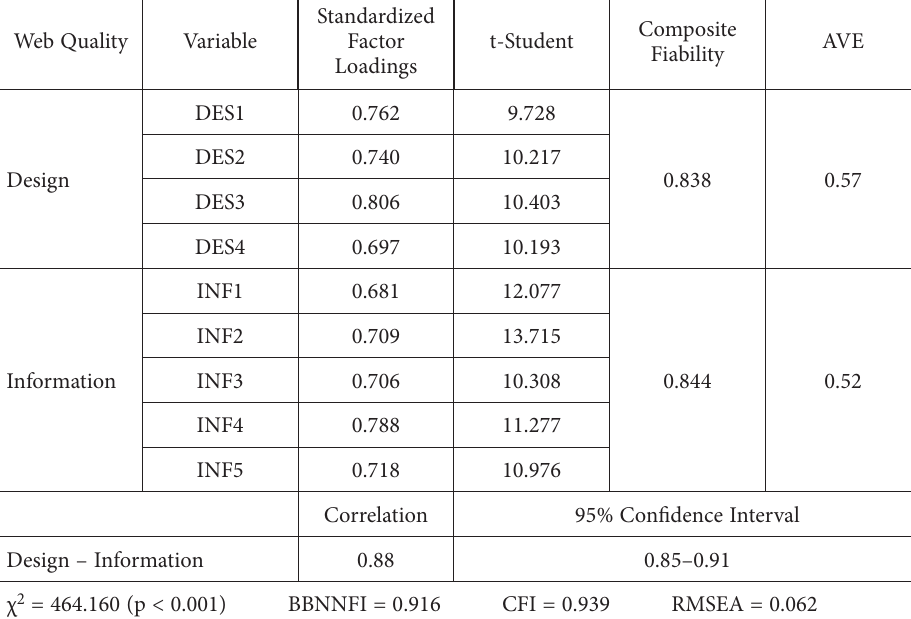
Table 4. Validity and reliability of utilitarian